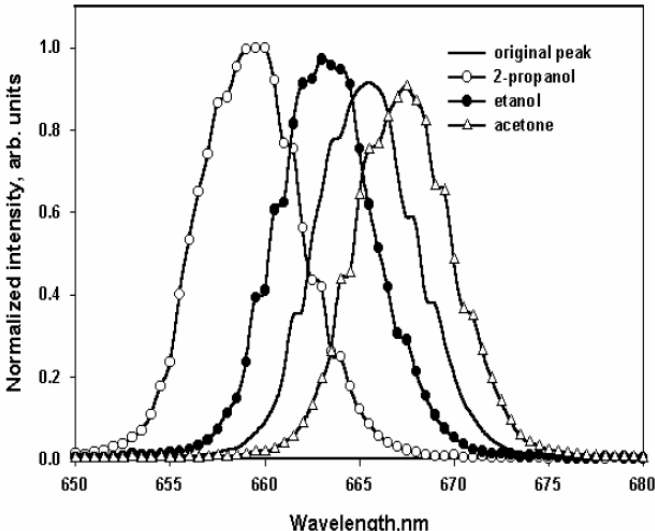
Figure 16. The emission spectra thin films of TiO ratio 1:2 at the original peak and in presence of 2-propanol, ethanol, and acetone. Reproduced with permission from